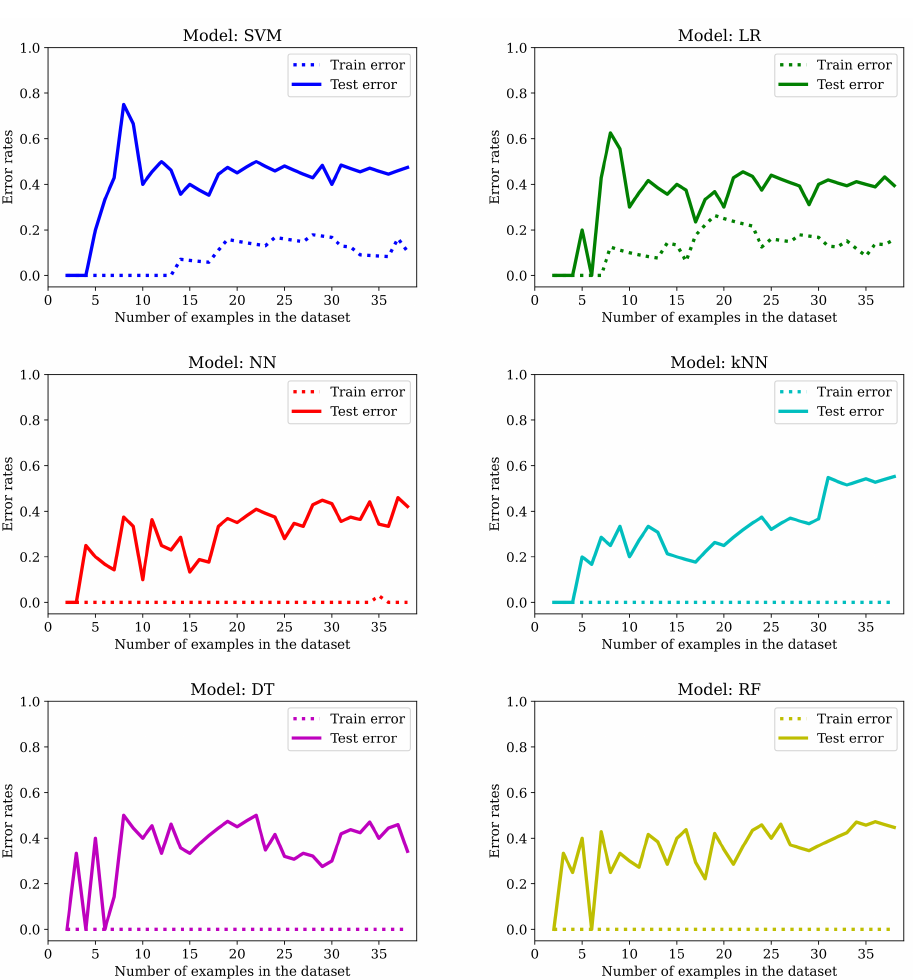
Figure 8. Evolution of error rates with increasing number of examples in training and testing phase for the original data set with selected features ( OrigD ∗